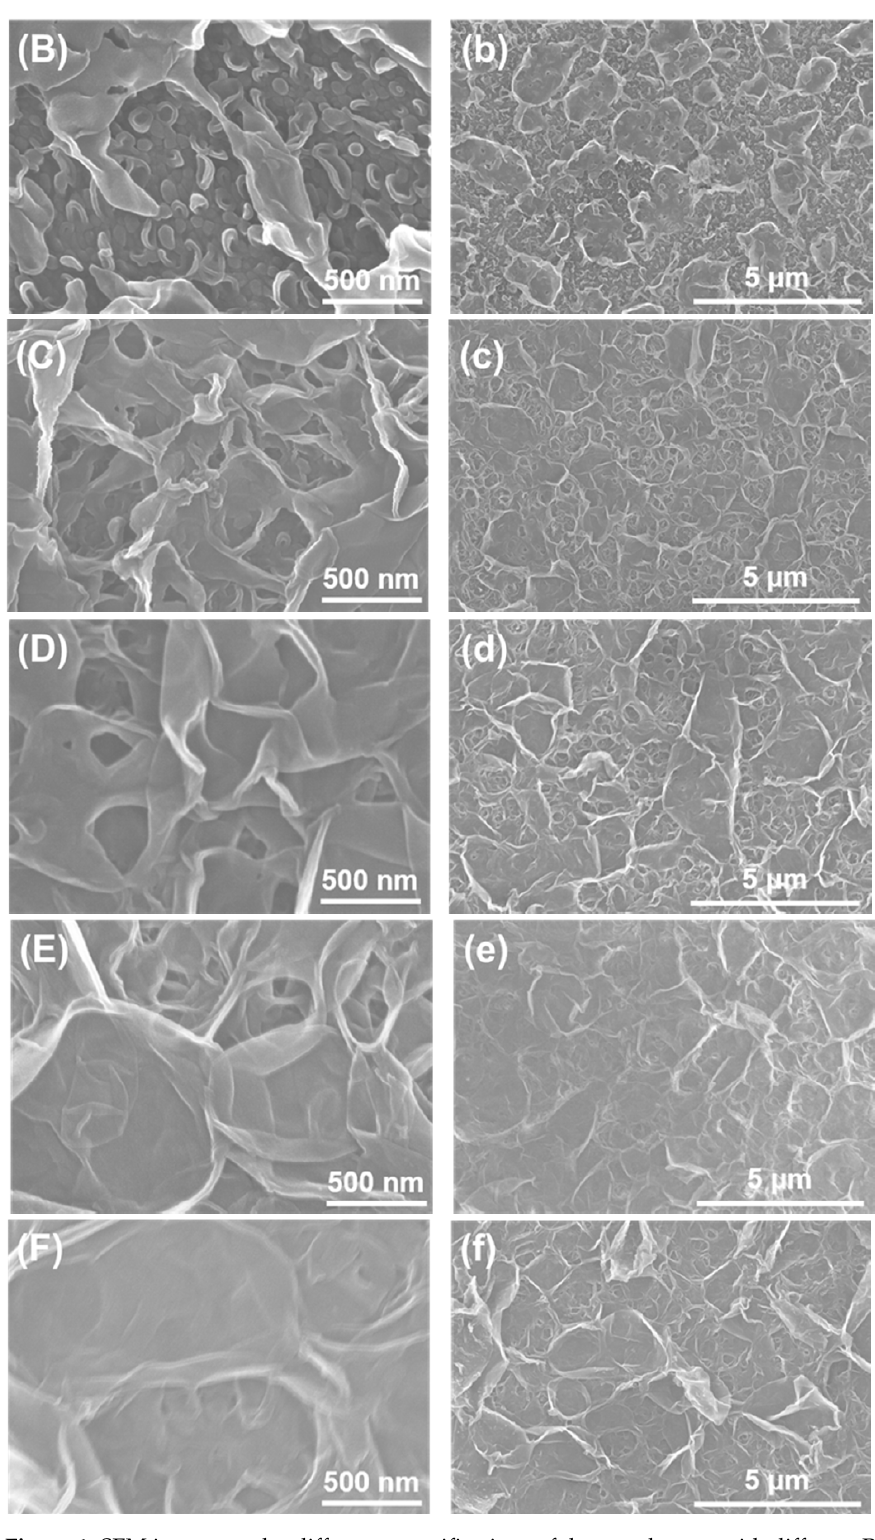
Figure 1. SEM images under different magnifications of the membranes with different PTS loading: ( A , a ) TFC membrane; ( B , b ) thin-film nanocomposite (TFN)-0.1 membrane; ( C , c ) TFN-0.2 membrane; ( D , d ) TFN-0.3 membrane; ( E , e ) TFN-0.4 membrane; ( F , f ) TFN-0.5